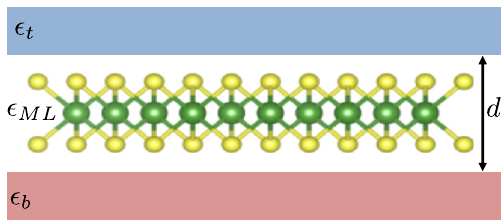
FIG. 2. Direct and indirect excitons in the time-reversed K -point valleys. Panels (a) and (b) show the involved electronic states in tungsten- and molybdenum-based monolayers, respec- tively. The indirect exciton has lower energy in the former case. Spin of the bands is color coded, and Δ is the conduction-band splitting energy.